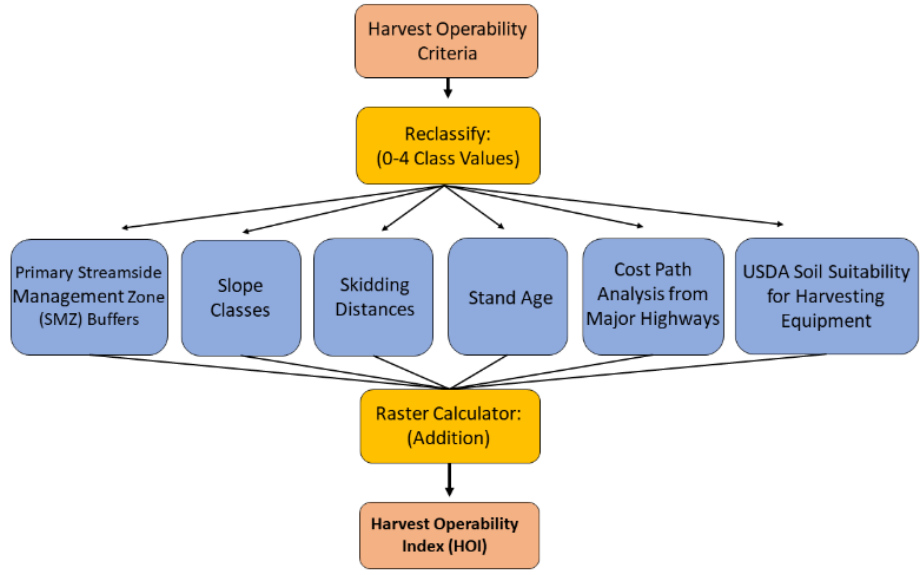
Figure 1. HOI conceptual diagram, illustrating the ArcGIS workflow. Each data criteria (blue) were reclassified to a 0–4 class value scale before raster calculator addition. Table 1. Rescaled HOI values on a 5-tier scale of operability.